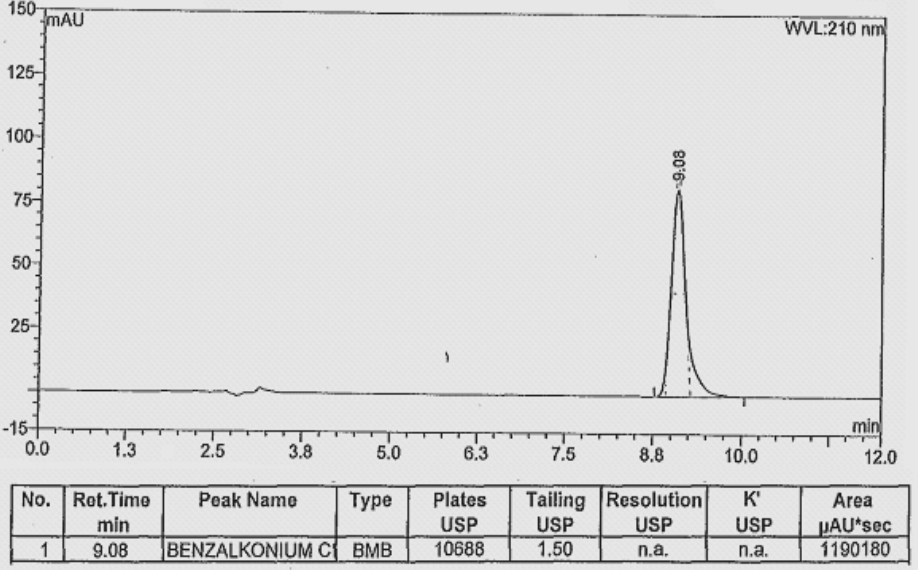
Figure 2. Standard system suitability chromatogram